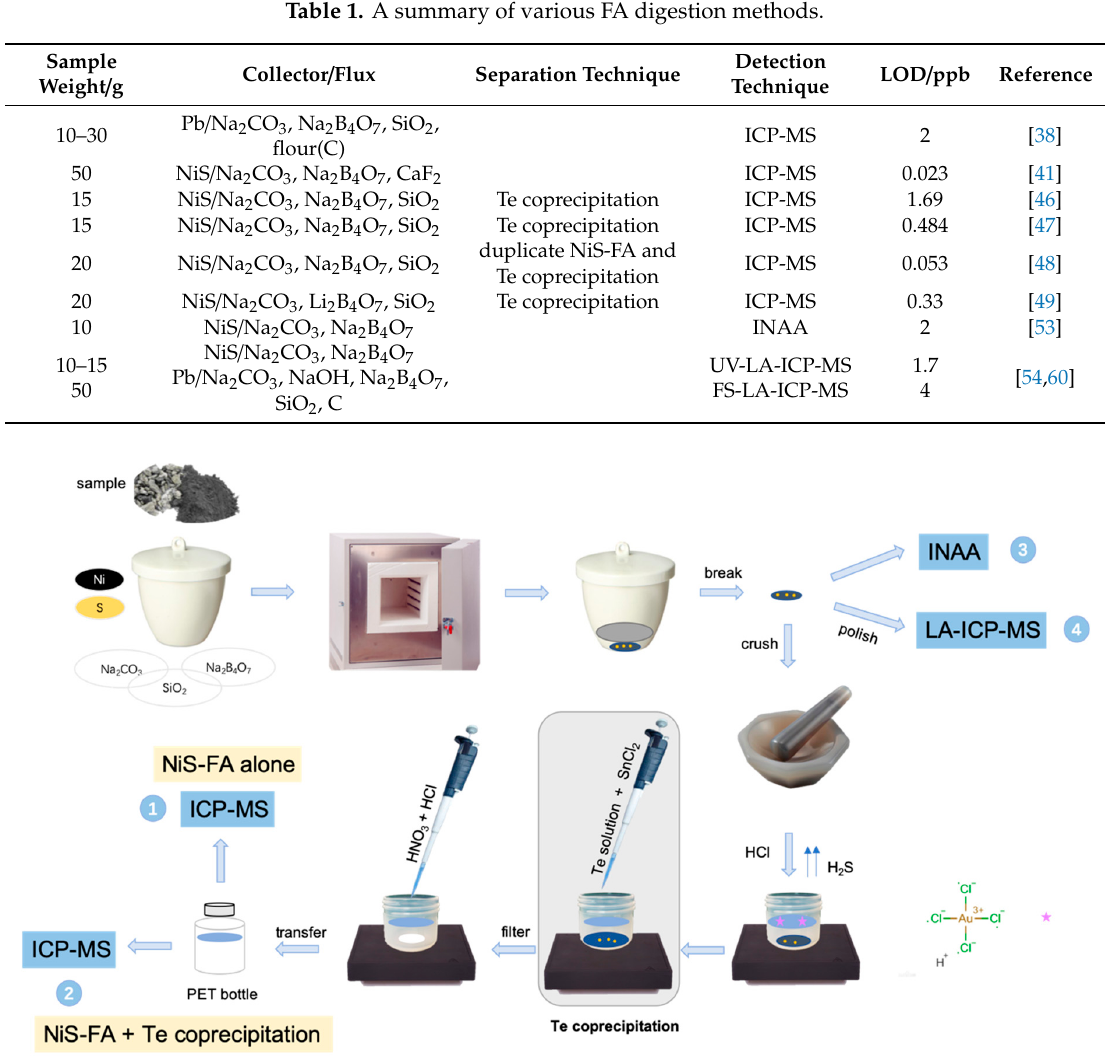
Figure 3. Main stages of the gold determination by the NiS-FA method. Table 1. A summary of various FA digestion methods.